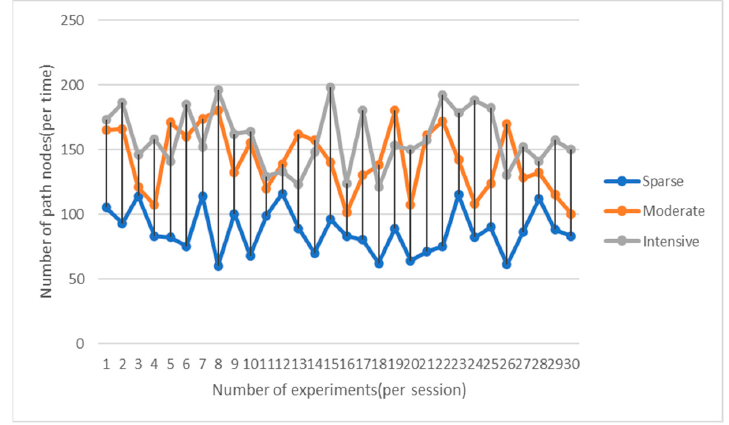
Figure 20. Comparison of the number of path nodes in the scene with dense obstacles.